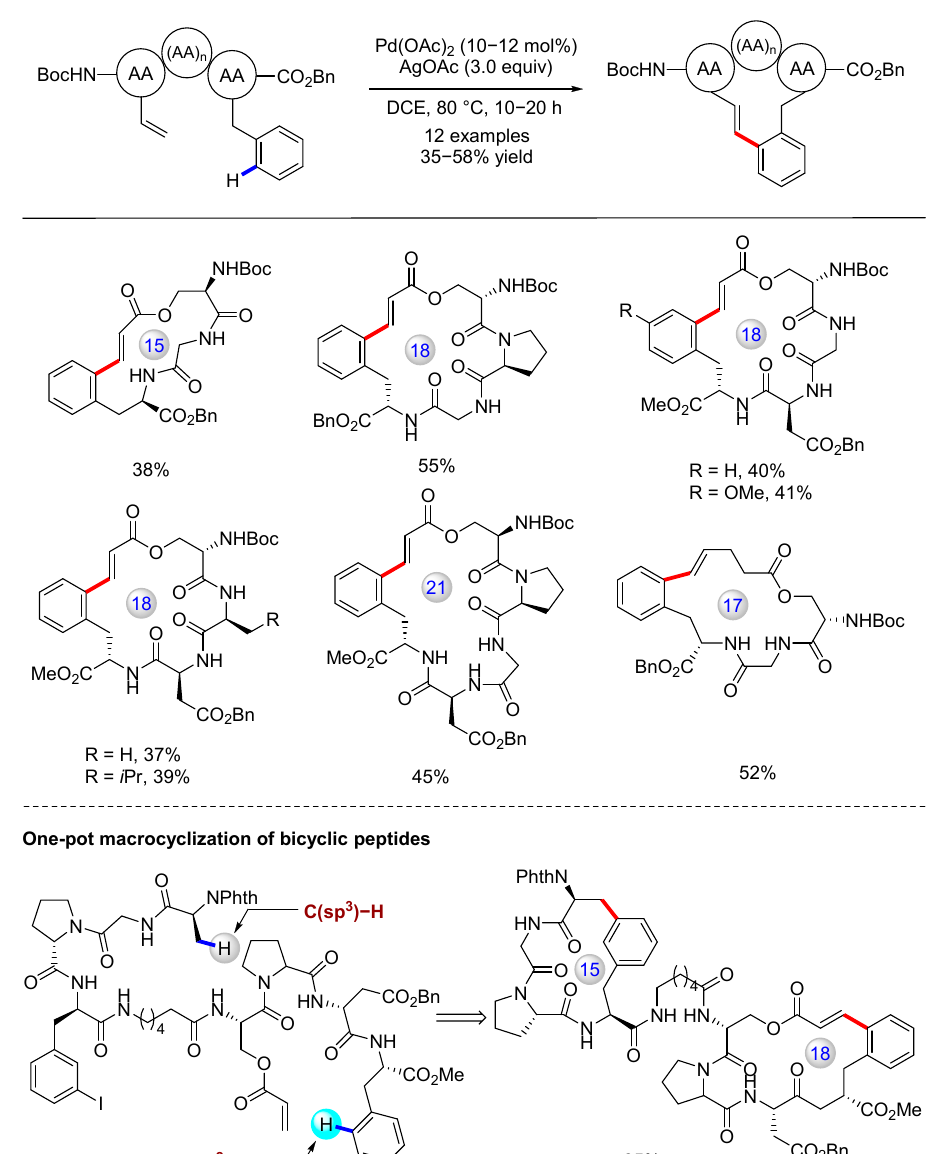
Figure 14. Peptide macrocyclization via Pd(II) ‐ catalyzed intramolecular δ‐ C(sp 2 ) − H ole fi nation of phenylalanines [73].